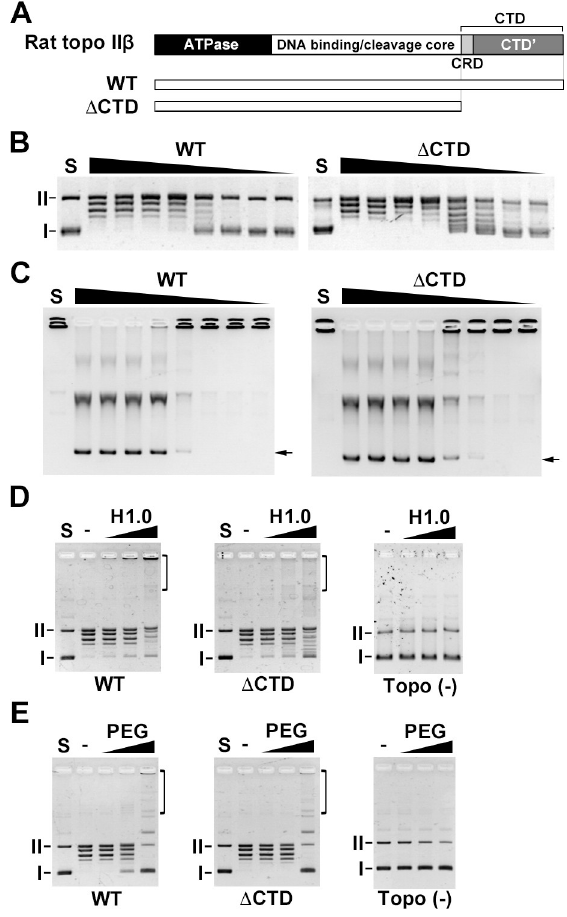
Fig 1. The CTD of rat topo II β is required for efficient in vitro catenation. (A) Structures of rat topo II β and the CTD truncation mutant. (B) The relaxation assay was performed with 2-fold serially-diluted enzyme (2 0 = 100 fmol) and 50 ng pUC18. (C) The decatenation assay was performed with 2-fold serially-diluted enzyme (2 0 = 100 fmol) and 100 ng kDNA. (D) Purified FLAG-tagged proteins (100 fmol) were used for catenation assay in the presence of histone H1.0 (1, 2 and 4 μ g/mL) as a DNA aggregation factor. Deproteinized samples were analyzed by 1% agarose gel. (E) Catenation assay in the presence of PEG (1, 5 and 10%). I: supercoiled DNA. II: nicked circular DNA. Brackets indicate